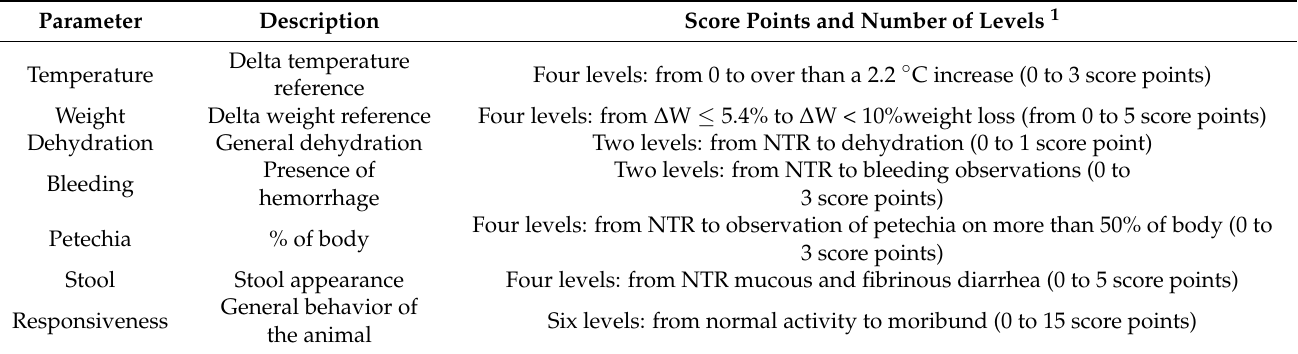
Table 1. Clinical